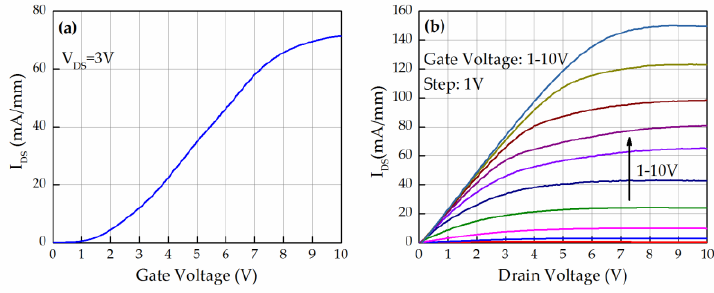
Figure 3. DC characteristics of a p-GaN HEMT, ( a ) the transfer characteristics, ( b ) the I-V output characteristics.